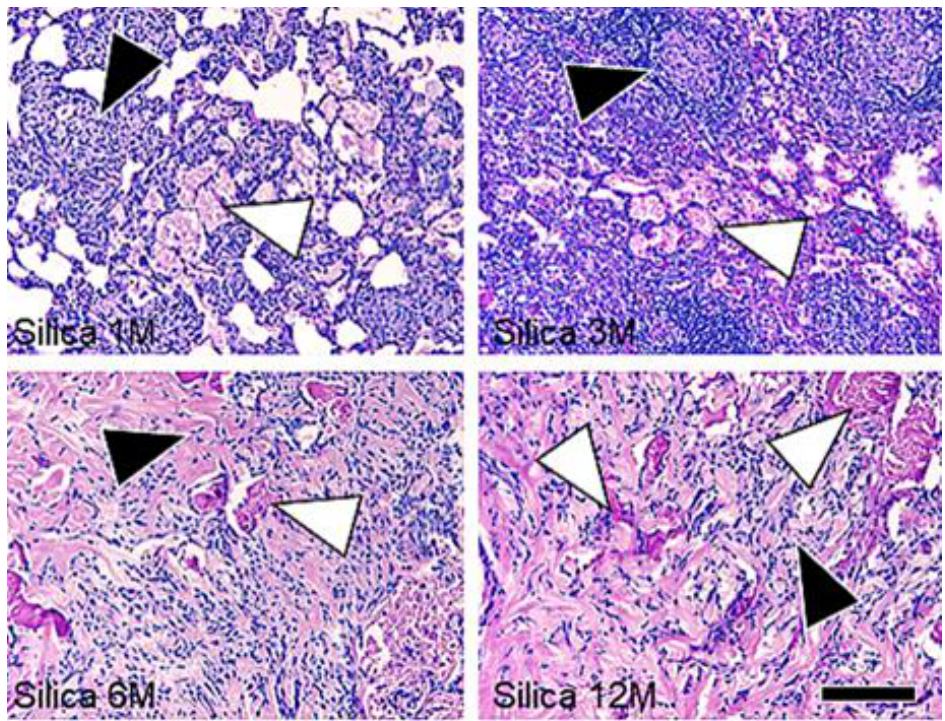
Figure 3. Microscopic findings of the fibrotic lesions of the lung tissue sections stained with Periodic acid Schiff stain. Proteinosis (white arrow heads) adjacent to the fibrotic lesions (black arrow heads) is observed in the lung of the treated rats. Bar = 150 μm. M: Month.